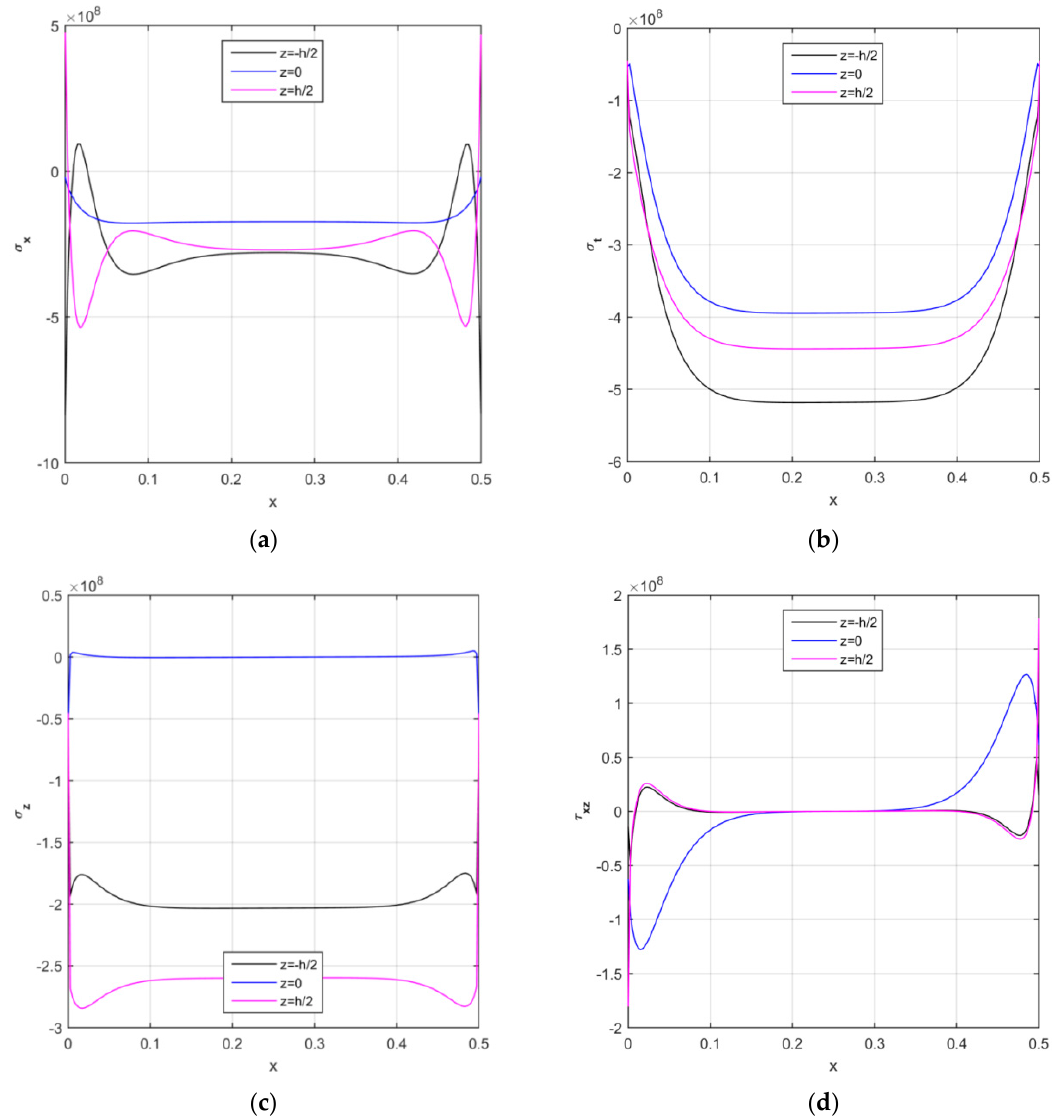
Figure 10. The longitudinal distribution of the axial ( a ), circumferential ( b ), radial ( c ), and shear ( d ) stress components [Pa] at different surfaces of the CNTRC cylinder.